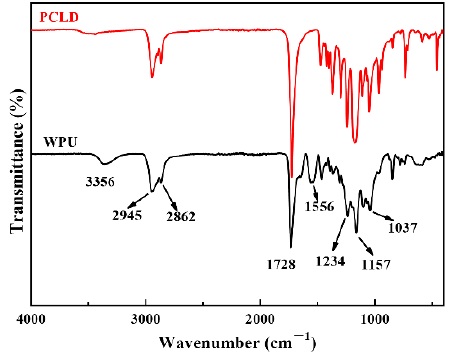
Figure 1. ATR-FTIR spectra of WPU-A1 and PCLD.